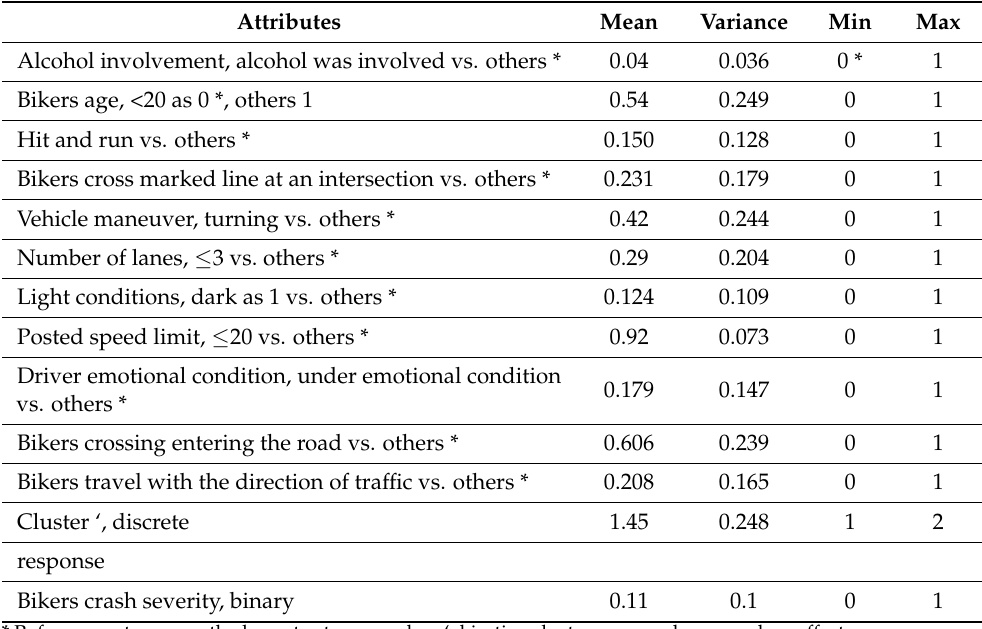
Table 1. Attributes and response of significant attributes in the statistical analysis. Attributes Mean Variance Min Max Alcohol involvement, alcohol was involved vs. others * 0.04 0.036 0 * 1 0.54 0.249 0 1 0.150 0.128 0 1 0.231 0.179 0.42 0.29